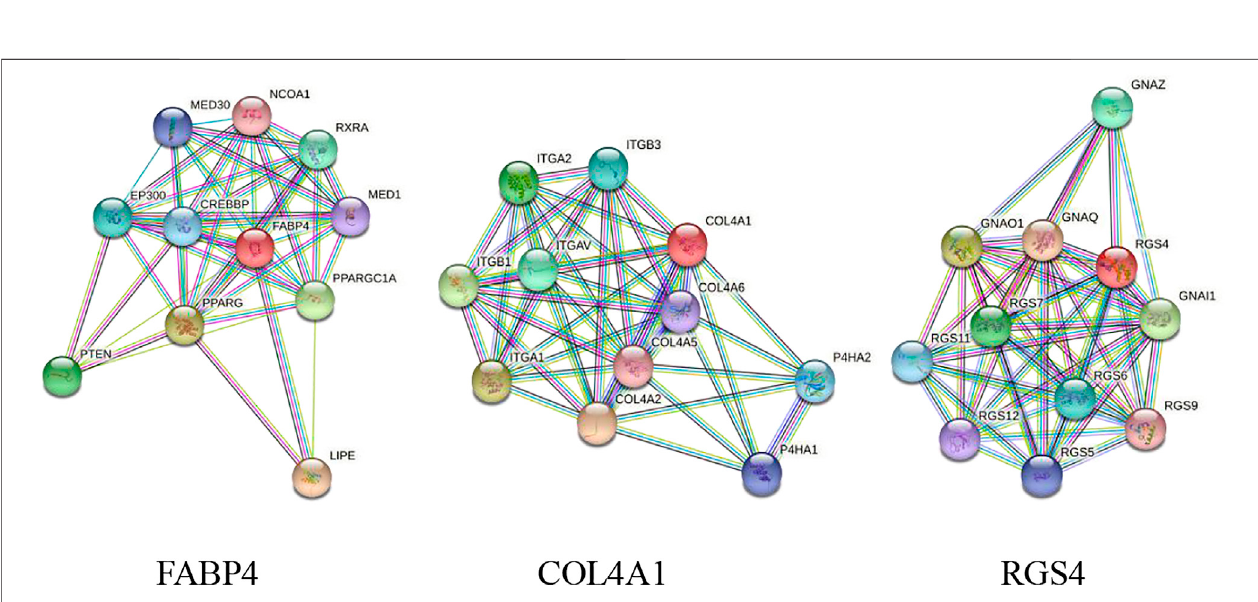
Frontiers in Genetics |